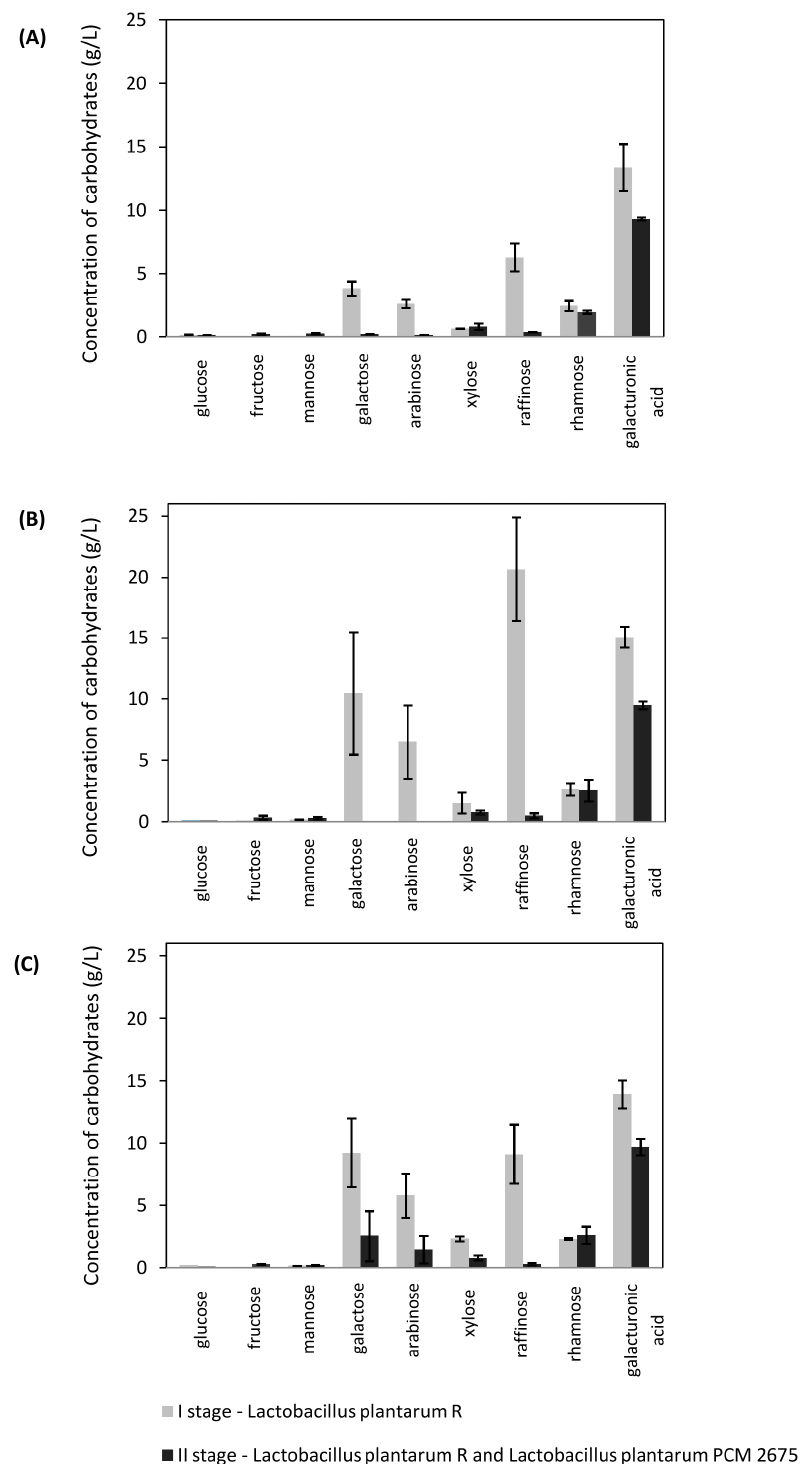
Figure 2. Concentration of carbohydrates (g/L) after ( A ) four hours, ( B ) 10 h, and ( C ) 16 h for I stage ( Lactobacillus plantarum R) and II stage ( Lactobacillus plantarum R and Lactobacillus plantarum PCM 2675).